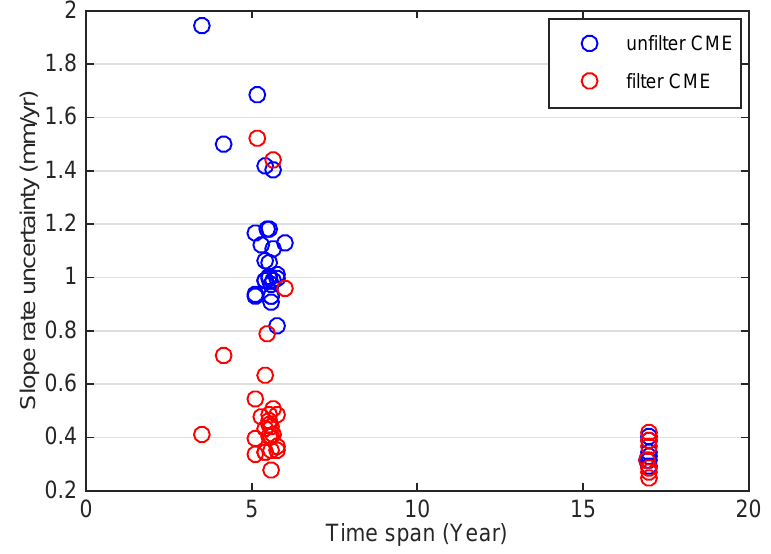
Figure 2. The slope rate uncertainty of common mode errors (CME) of GPS vertical velocity, blue dots are uncertainty with CME retained; red dots are with CME filtered.